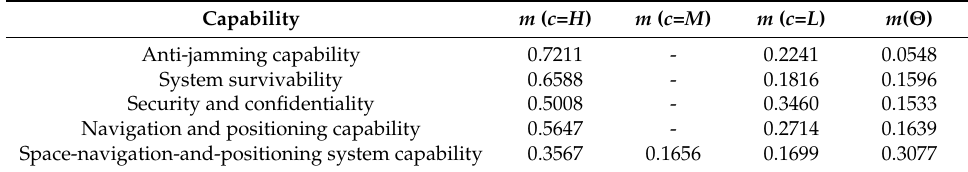
Table 4. The belief distribution of the requirement-satisfaction degree for each upper-layer capability.